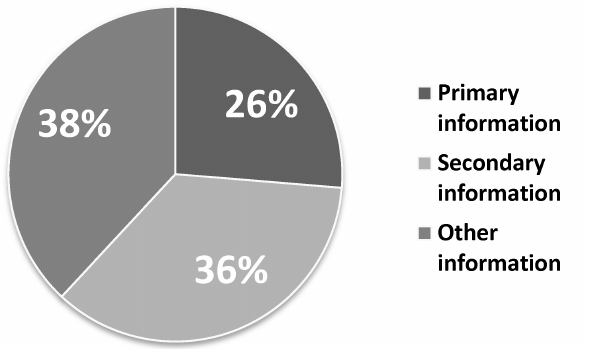
Figure 1. Ratio of primary, secondary and other information in tweets from the time of the Great East Japan